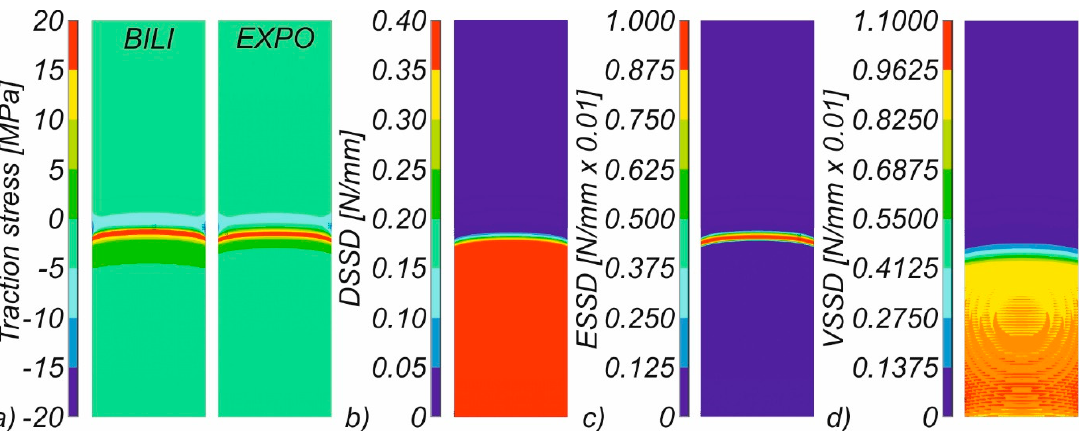
Figure 11. Contour maps of: traction stress ( a ); damage strain energy density ( b ); elastic strain energy density ( c ); and visco-regularization strain energy density ( d ).